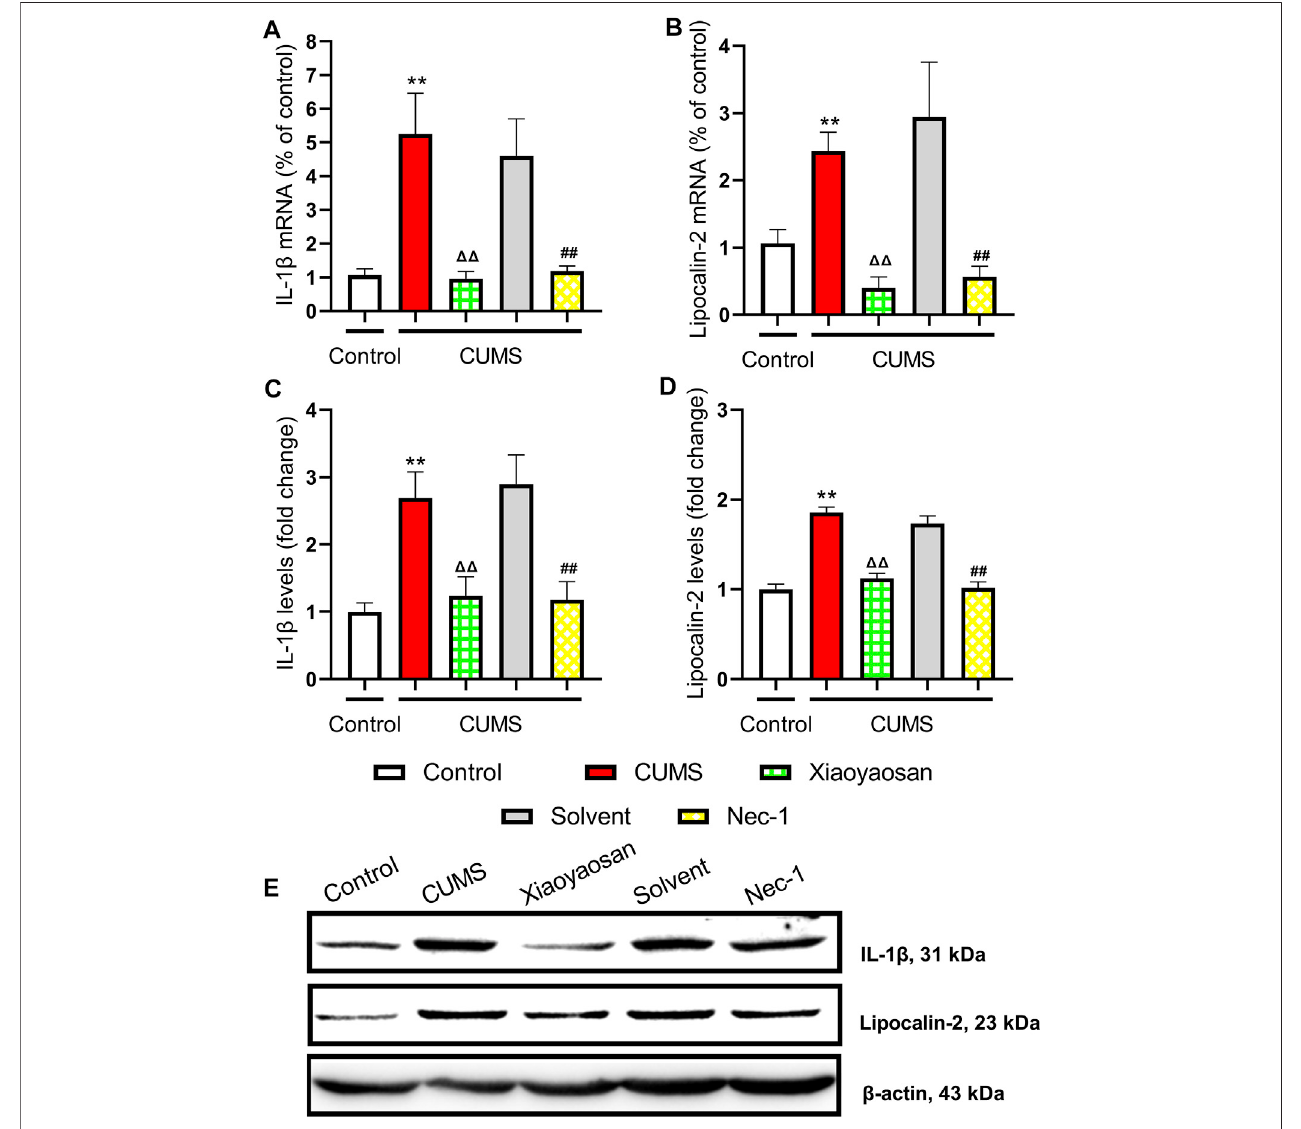
FIGURE10| ThelevelsofIL-1 β andLipocalin-2inthehippocampusofCUMSmice (A) ThemRNAresultsofIL-1 β (n (cid:1) 5) (B) ThemRNAresultsofLipocalin-2(n (cid:1) 5) (C) Theproteinresults ofIL-1 β (n (cid:1) 5) (D) Theprotein results ofLipocalin-2(n (cid:1) 5) (E) RepresentativemicrographsofWB forIL-1 β and Lipocalin-2. Datawereexpressed as means ± SEM, ** p < 0.01 versus control group; ΔΔ p < 0.01 versus CUMS group; ## p < 0.01 versus Solvent group.